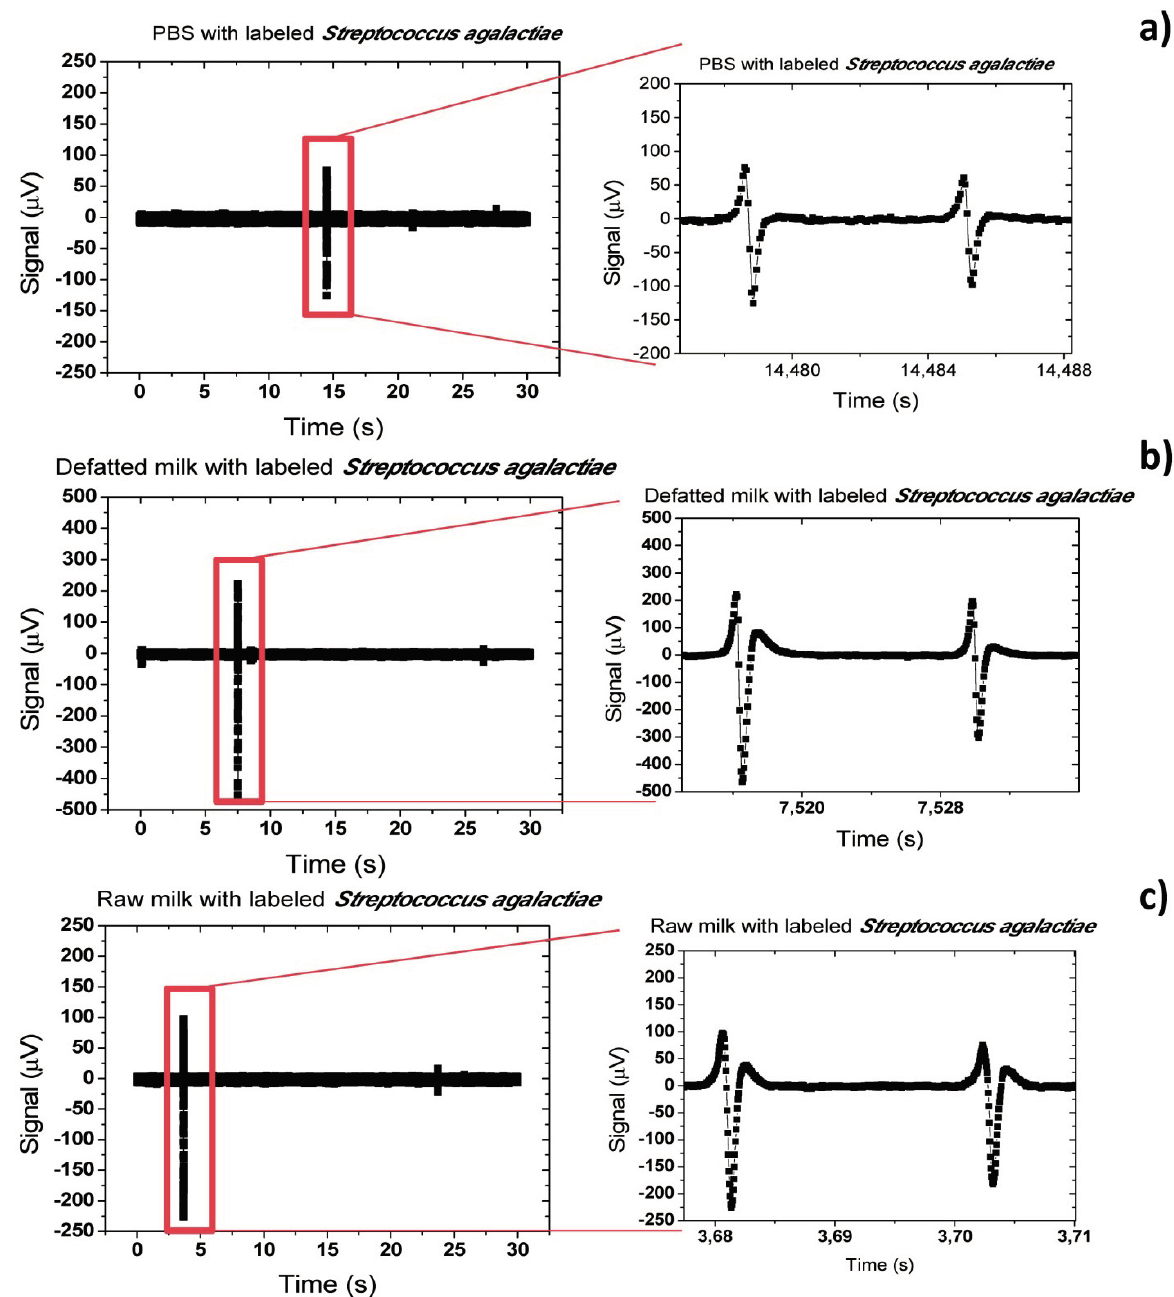
Figure 26. Acquisition signal of ( a ) PBS; ( b ) defatted and ( c ) raw milk samples spiked with magnetically labeled S treptococcus agalactiae cells at 50 μ